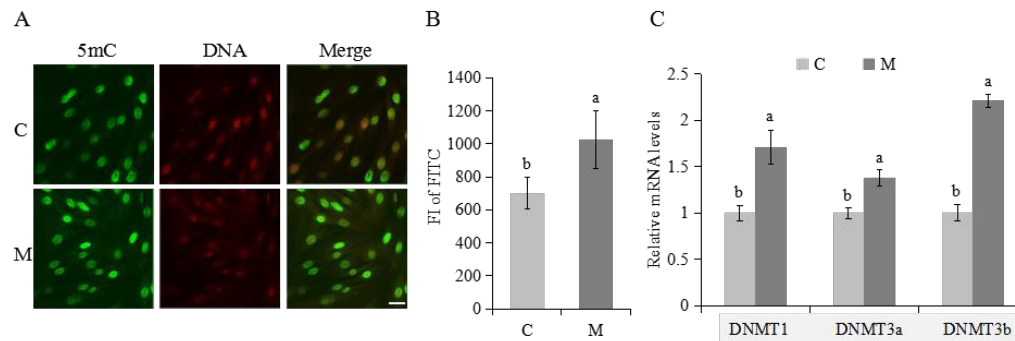
Figure 5. Abundance of 5-methylcytosine (5mC) and gene expression of DNMTs in cumulus cells collected from C and M groups; ( A ) Representative immunofluorescence images of 5mC (green), and propidium iodide-stained nuclei (red). Scale bars, 20 μm. ( B ) global 5mC DNA in cumulus cells. ( C ) relative mRNA levels of DNMTs . The experiments were repeated three times; data presented as mean ± SEM; a,b in Figure 5B and 5C, for adjacent columns, means without a common superscript differed ( p < 0.05).